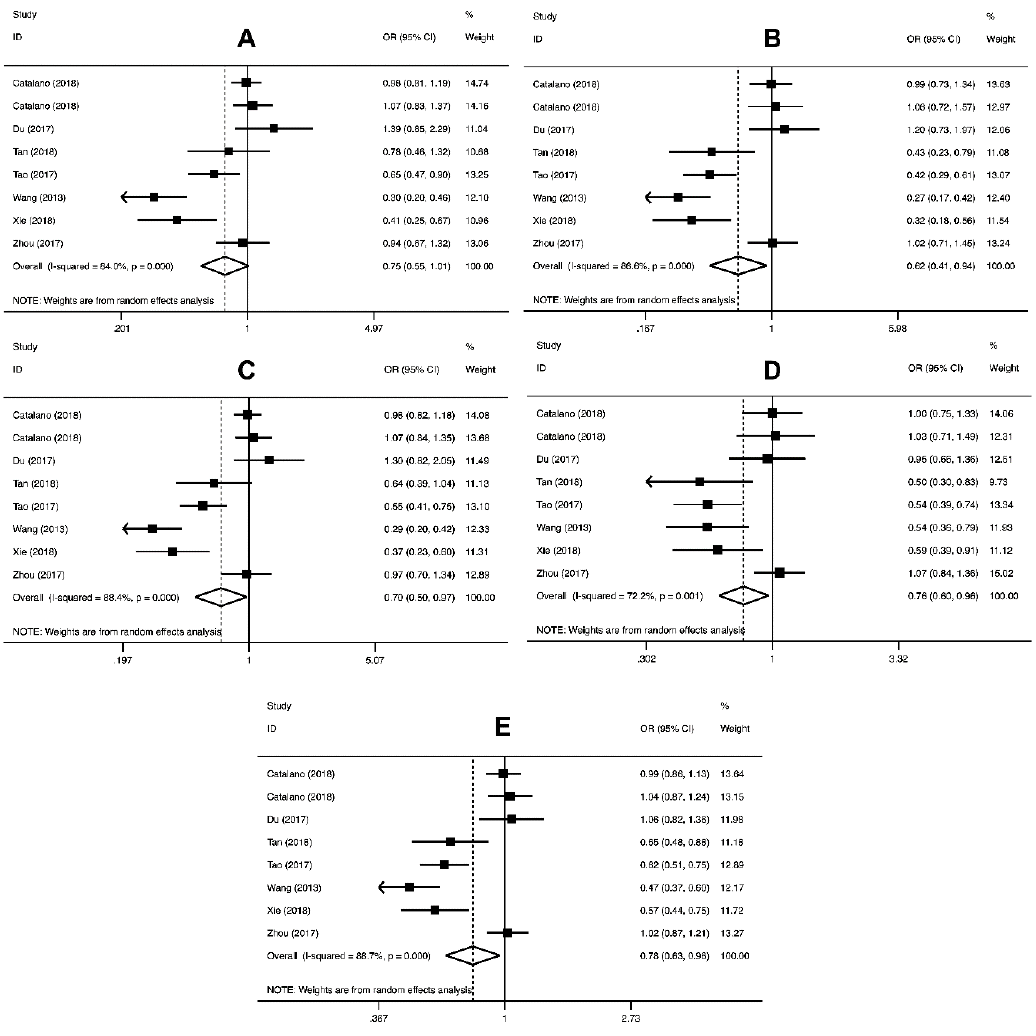
Figure 3. Forest plot of the relationship between PD-L1 rs4143815 polymorphism and cancer susceptibility for CG vs. GG ( A ), CC vs. GG ( B ), CG + CC vs. GG ( C ), CC vs. CG + GG ( D ), and C vs. G ( E ).